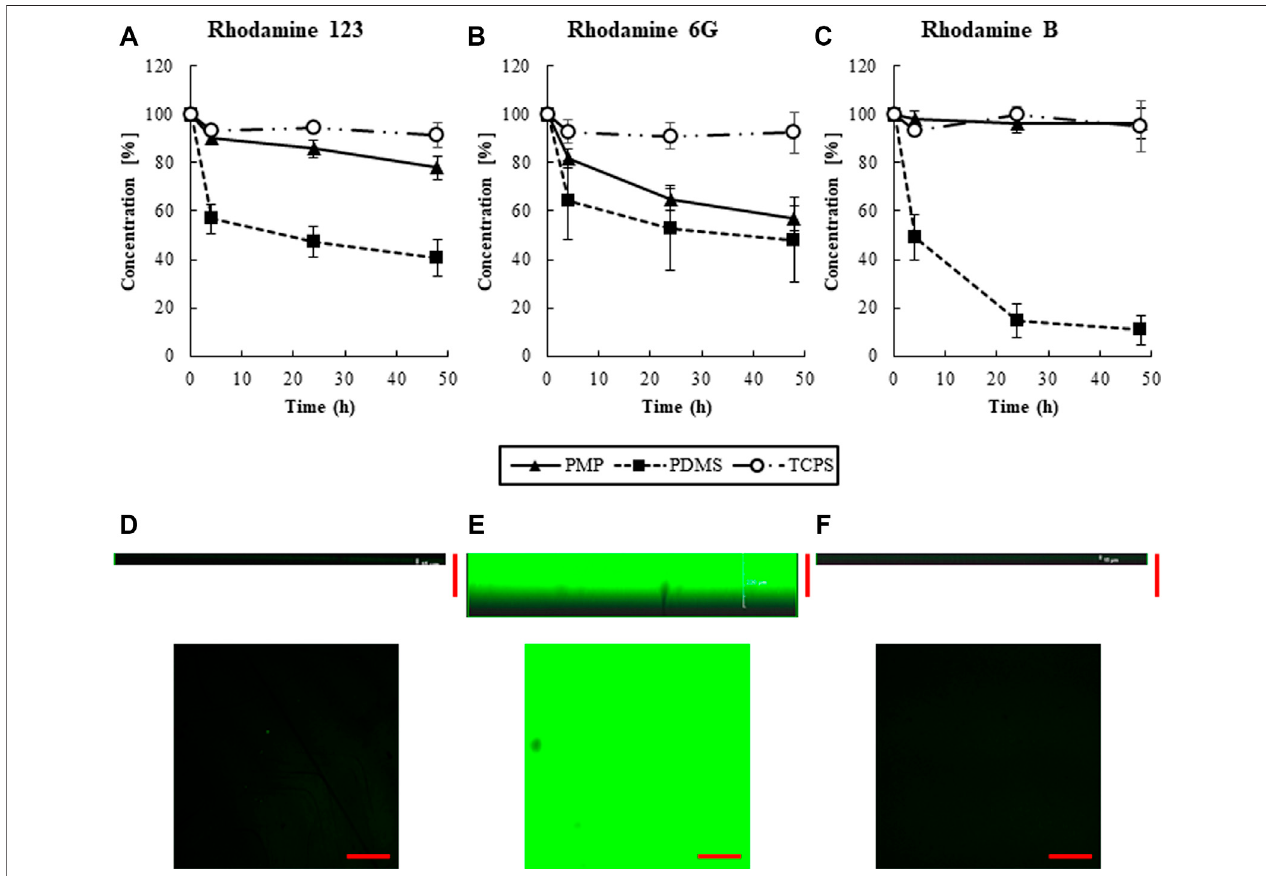
FIGURE 2 | The transition of the concentrations of (A) Rhodamine 123, (B) Rhodamine 6G, (C) Rhodamine B, respectively (N = 6). Cross section of 48 h after adding Rhodamine B solution. (D) PMP, (E) PDMS, and (F) TCPS. Scale bars represent 200 μ m.